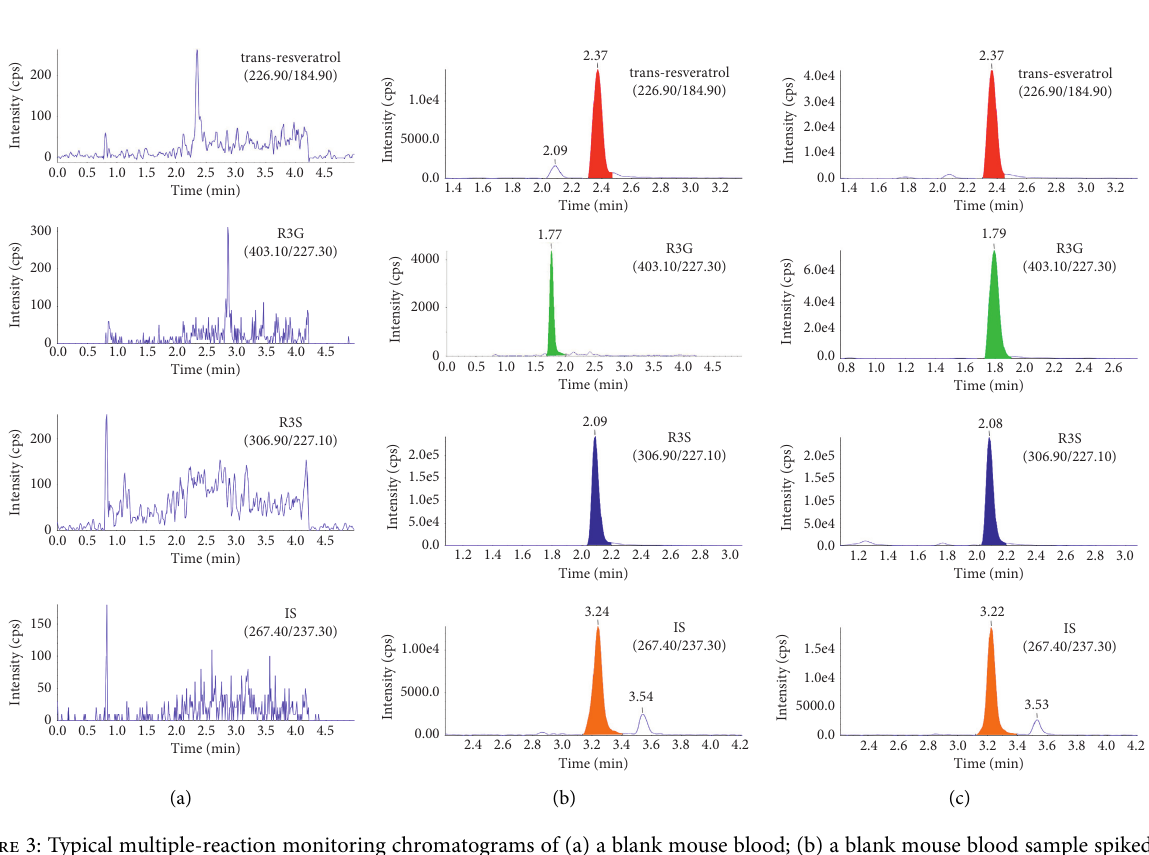
the endogenous interference could be ignored. The details of the results are presented in Table 3. The extraction recovery of the trans-resveratrol from the QC samples was 83.82 ± 8.12%, 79.97 ± 4.3%, and 79.66 ± 2.1% at three concentration levels (5.59, 22.35, and 111.75ng/mL, respectively; n � 6). The extraction recovery of the R3G from the QC samples was 89.28 ± 6.42%, 83.54 ± 8.38%, and 83.38 ± 2.04% at three concentration levels (5, 20, and 100ng/ mL, respectively; n � 6). The extraction recovery of the R3S from the QC samples was 89.46 ± 5.21%, 89.52 ± 1.52%, and 85.19 ± 2.98% at three concentration levels (5, 20, and 100ng/ mL, respectively; n � 6). In addition, the extraction recovery of the IS was 99.94 ± 4.78%. The consistency in the recovery of the trans-resveratrol, R3G, R3S, and IS supported the suitability of the extraction procedure for routine sample analysis. The de- tailed results are presented in Table 3.